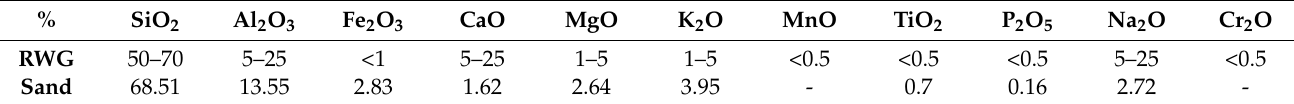
Table 2. Physical properties of different used aggregates.